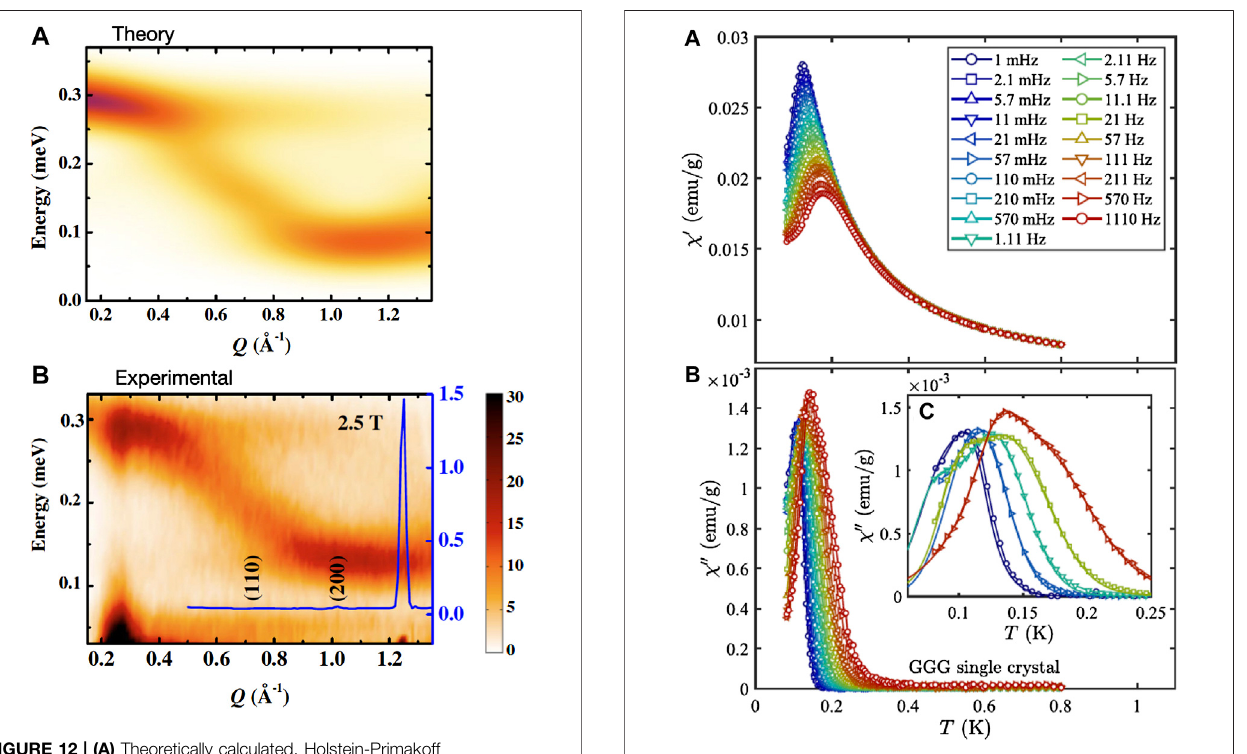
FIGURE 13 | Temperature and frequency dependence of (A) the real ( χ ′ and (B) imaginary ( χ ′′ ) AC susceptibliity on a single crystal of GGG measured along the (110) direction. The frequencies, 1 mHz < f < 1110 Hz, are indicated by color (inset) Detailed view of χ ′′ for selected